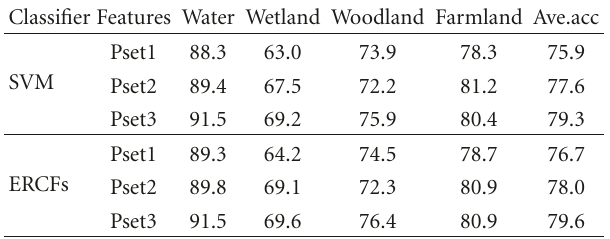
Table 5: Classification performances(%) of SVM and ERCFs with Pset1, Pset2, and Pset3.